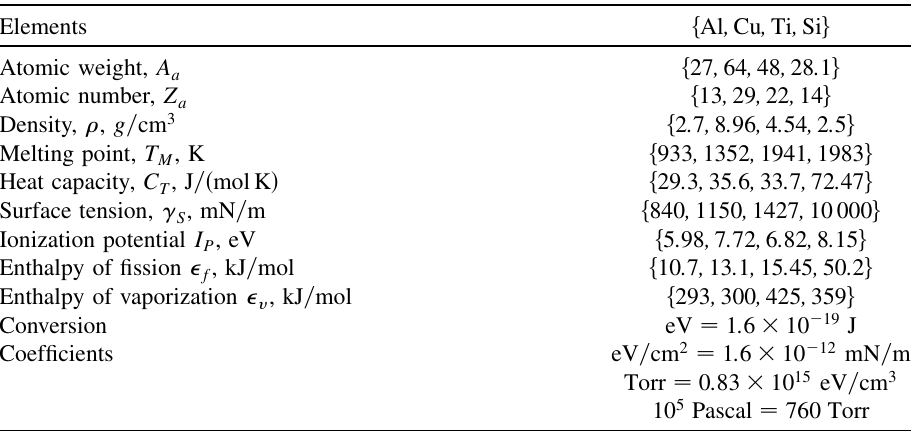
TABLE II. Some relevant parameters.